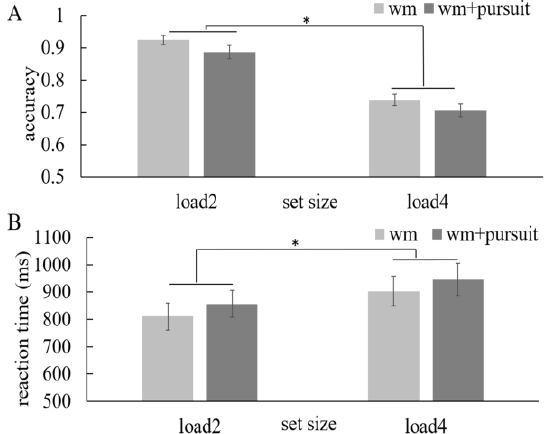
Figure 2. The WM performance with and without pursuit task. Light grey indicates the WM performance in the WM-only session and dark grey indicates the WM performance in the WM + pursuit session. (A) accuracy, (B) reaction times. Error bars represent standard error and asterisks indicate significance at p < 0.05.